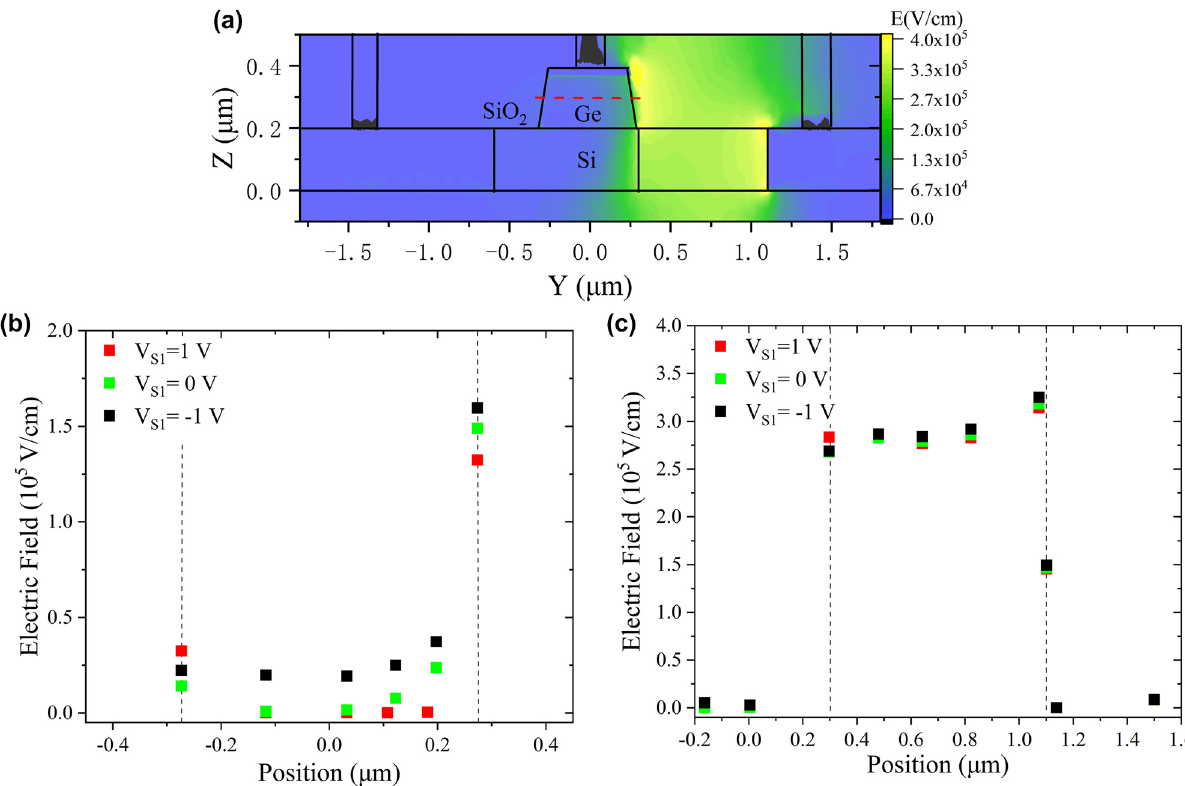
Figure 2: The electrical field distribution of the detector. (a) The simulated two-dimensional electric field distribution of the cross-section plane. (b) Simulated electrical field distribution along the longitudinal cross section at the center of the Ge layer with different V distribution of the multiplication layer with different V S1